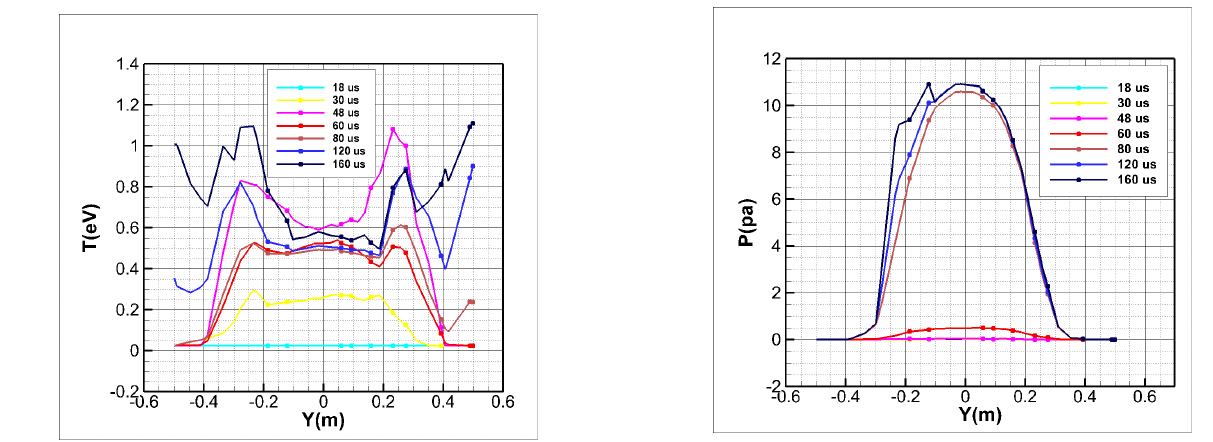
Figure 12. Variation curves of temperature and pressure along the y-direction on a specific line.